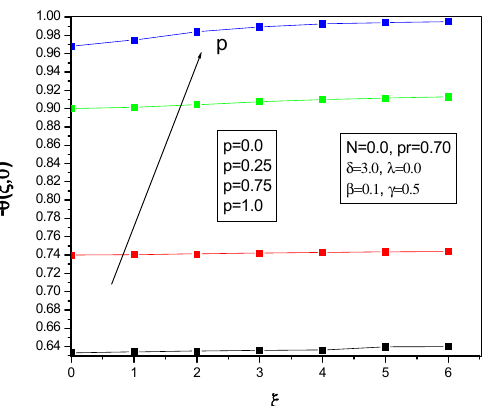
Figure 13. Effect of the velocity exponent and buoyancy force parameter on the Nusselt number.